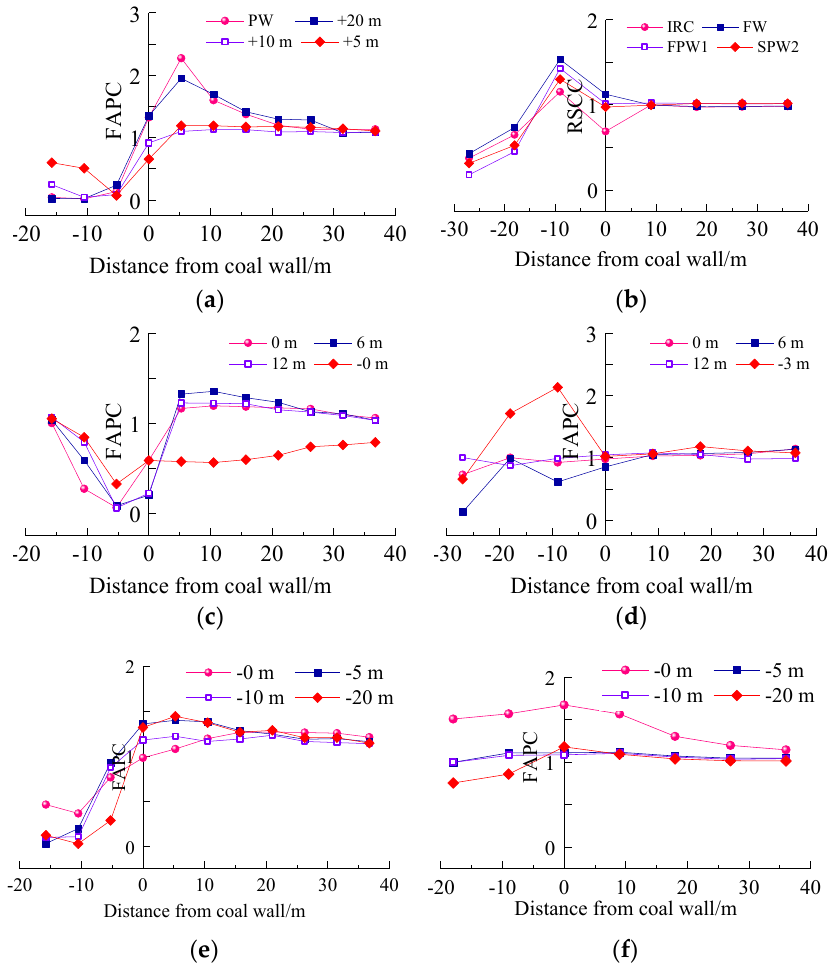
Figure 15. By passing the coal pillar, the change of FAPC and 24 m layer RSCC: ( a ) FAPC before coal pillar. ( b ) 24 m layer RSCC before coal pillar. ( c ) FAPC enter the coal pillar. ( d ) 24 m layer RSCC enter the coal pillar. ( e ) FAPC out coal pillar. ( f ) 24 m layer RSCC out coal pillar.